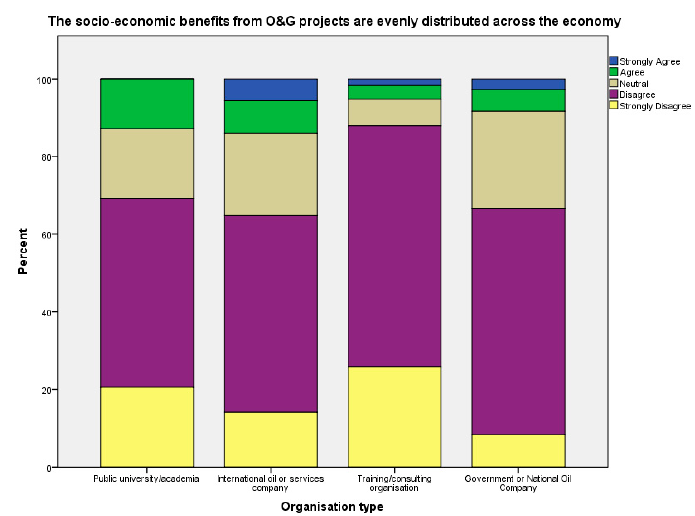
Figure 3. Responses by organization type to “the socio-economic benefits from oil and gas projects are evenly distributed across the economy”.